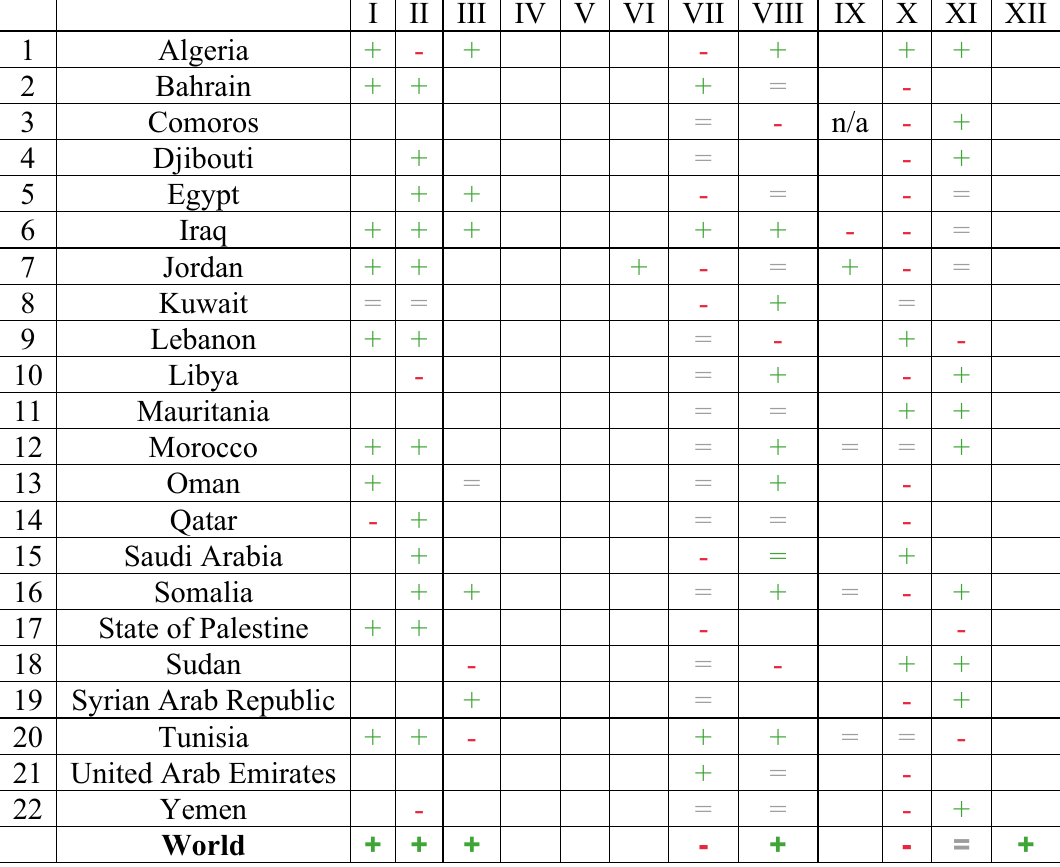
+ Positive trend - Negative trend ; (−), ; (=),